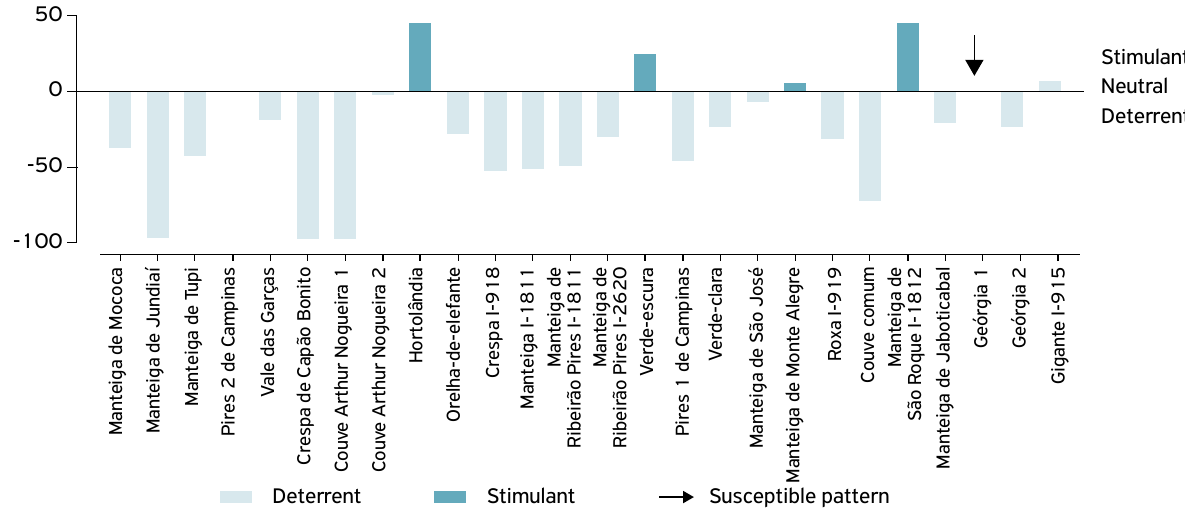
Figure 5. Oviposition preference index of adults of Ascia monuste orseis (Lepidoptera: Pieridae) in collard greens genotypes in free- choice test (temperature 25 ± 2ºC, relative humidity 70 ± 10% and photoperiod 12:12